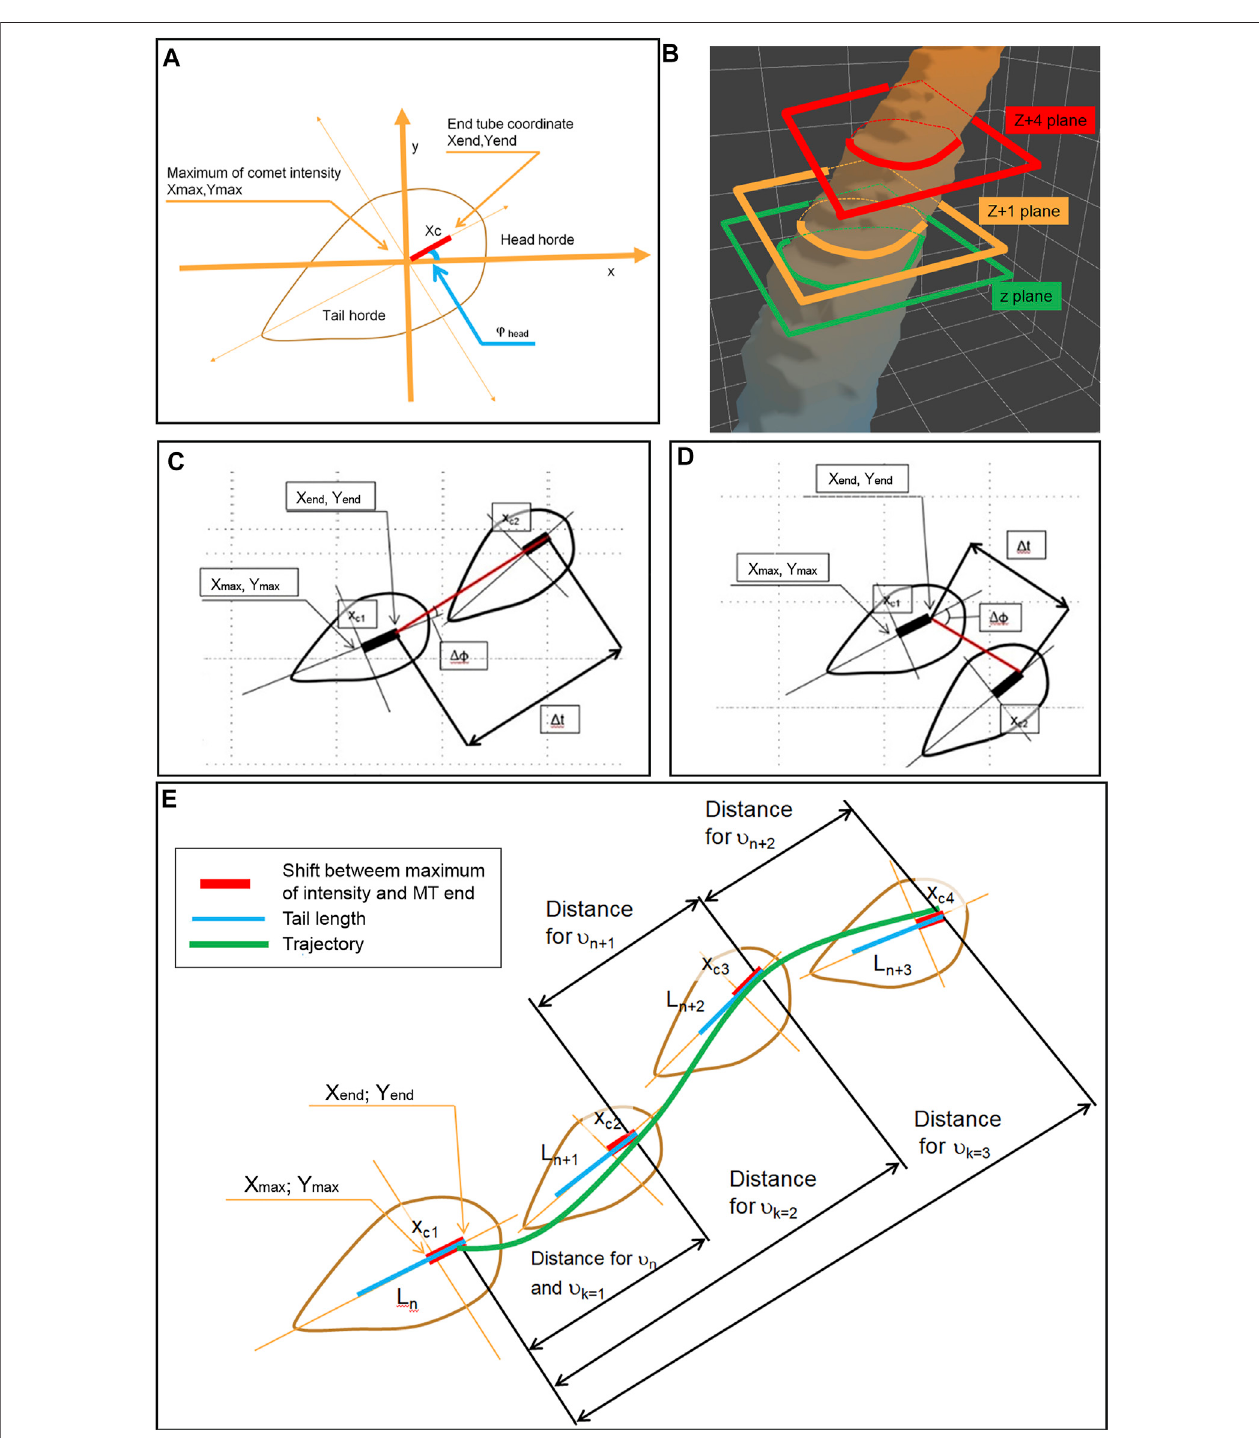
FIGURE 5 | Determination of the MT growth trajectory and measurements of the velocity by determination of the head horde and scheme of MT end coordinate measurements (A) andbyneighborplanes, zandz+1, relatestotimetand timet+1onthetopologicalobject (B) .Theplanez+4relatestot+4incasewhenthedirection of a comet (head-to-tail axis) is close to MT growing direction (red line) (C) and in case where the direction of a comet is different from MT growing direction (D) . (E) The velocity measurements performed on the comets with both directions coinciding (with L n , L n+1 , L n+2 , and L n+3 were measured sequentially). The distances for the measurement of v n , v n+1 , and v n+2 are shown. Also, distances for calculation v k (cid:1) 1 v k (cid:1) 2 v k (cid:1) 3 are shown. The green line shows the splined trajectory of the MT growth over few frames.